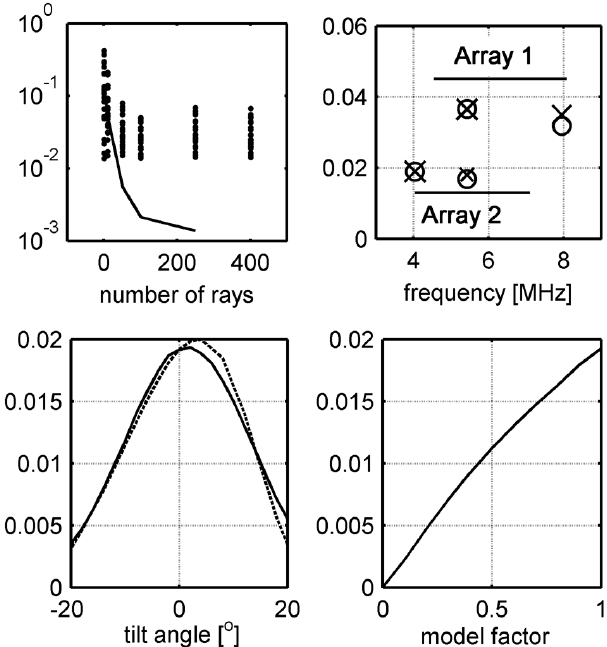
Fig. 5. Model sensitivity tests. All panels show modelled absorp- tion differences in dB. Upper left panel: Integrated absorption dif- ference vs. number of tesselations used in the 3-D model (points) and deviation from the 401-point case (solid line). Upper right panel: The effect of heater frequency calculated for the winter-time medium electron density case and both o - and x -modes. Solid lines represent the full frequency ranges of the two antenna fields. Lower left panel: The effect of possible IRIS beam horizontal (solid line) and vertical (dashed line) misalignment. Lower right panel: The effect of the model production/loss scaling factor k explained in Sect.